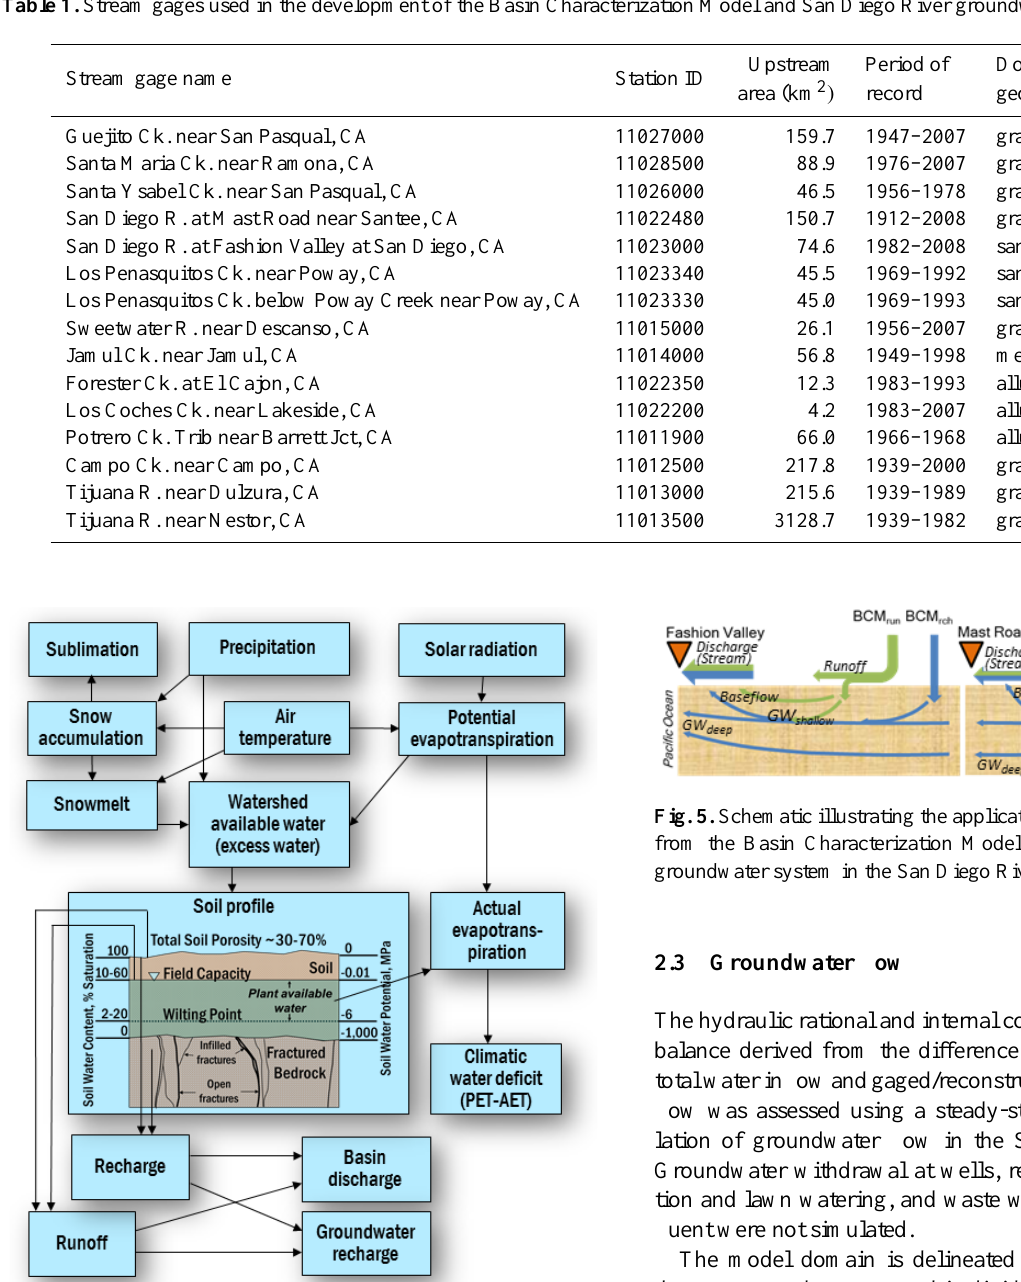
Fig. 4. Schematic illustrating the relation among the various com- ponents of the Basin Characterization Model.